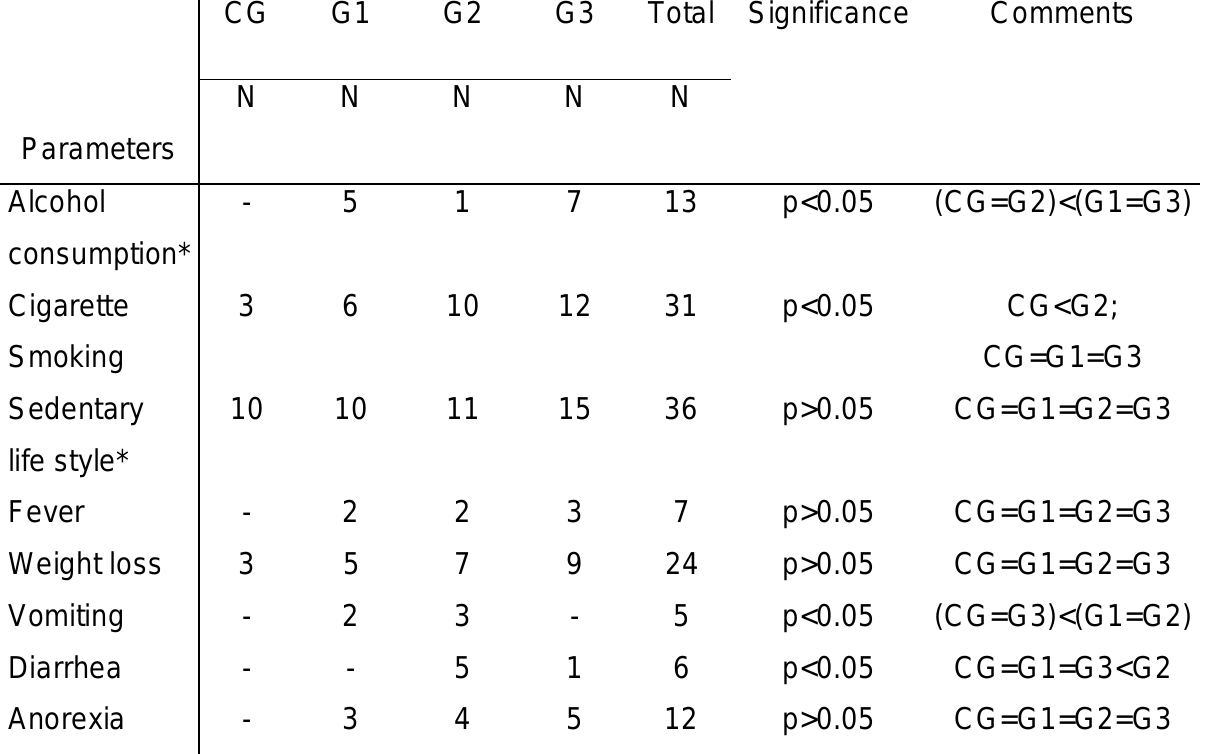
Table 1. Distribution of the 62 subjects, HIV-1 infected or not, according to the presence of clinical-epidemiological parameters. CG: Control group, blood